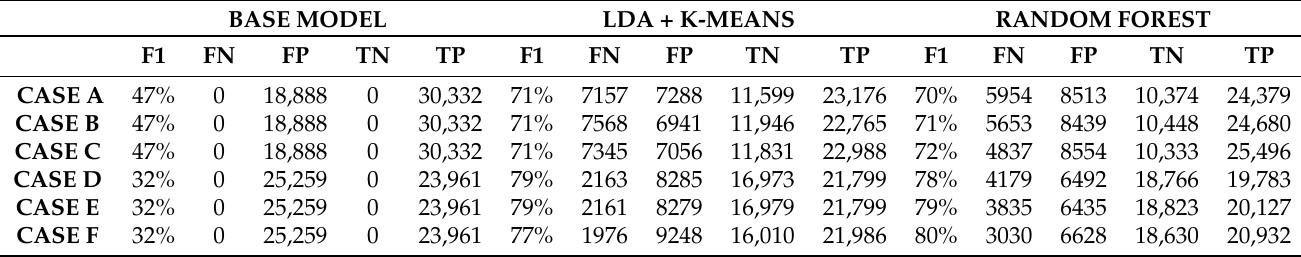
Table 3. Accuracy metrics for base model, LDA + K-Means, and Random Forest. F1 score (F1), False Negatives (FN), False Positives (FP), True Negatives (TN), and True Positives